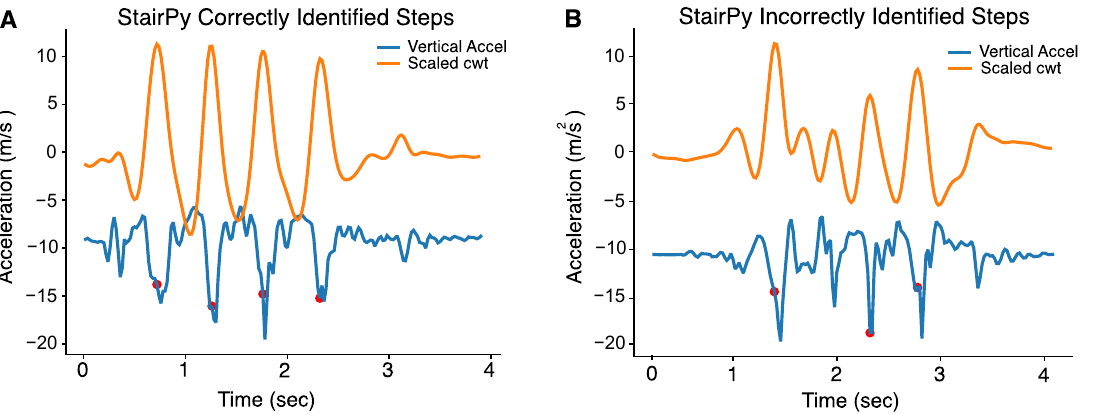
Figure 3. ( A ) Example of correctly identified steps, as four contacts were identified (red) and ( B ) An example of misidentified second step, where only 3 contacts were identified (red) (second step not identified).